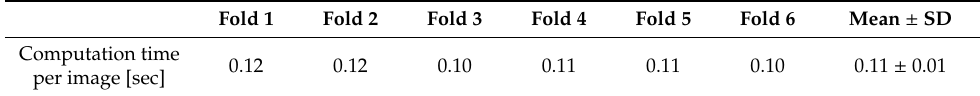
Figure 5. The accuracy rates of delineation for the standard line. The blue asterisks indicate the mean accuracy rates of the OM-line. The red circles show the mean accuracy rates of the AC-PC line. The error bars show the standard deviation. Table 4. The processing speeds of calculating the standard